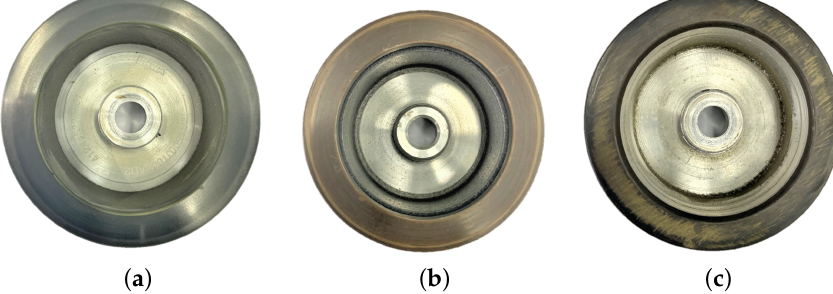
Figure 4. Pictures of the grinding wheel at ( a ) healthy/normal state, ( b ) fairly used